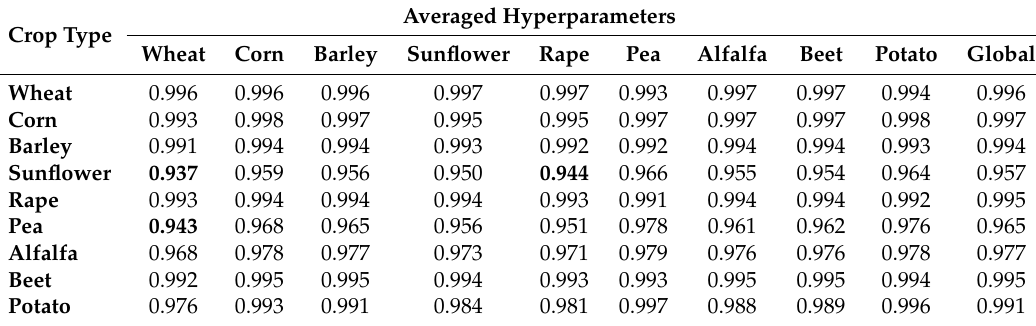
Table 4. Mean correlation analysis between the LAI time series estimated by precalculated and per-pixel optimized kernel hyperparameters (lowest values in